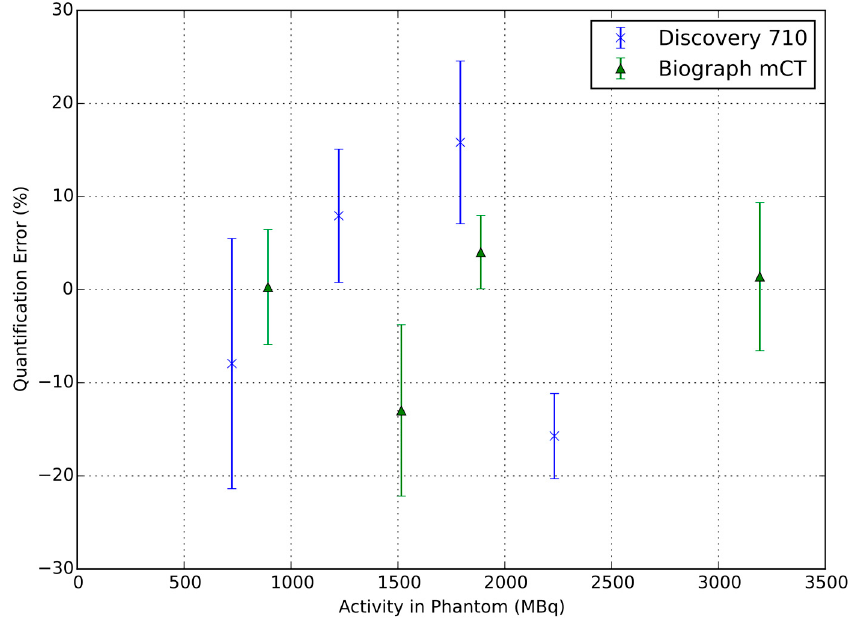
Figure 1. The quantification accuracy from the seven background regions in images from the Discovery 710 and Biograph mCT when the phantom was static. Error bars represent standard errors.